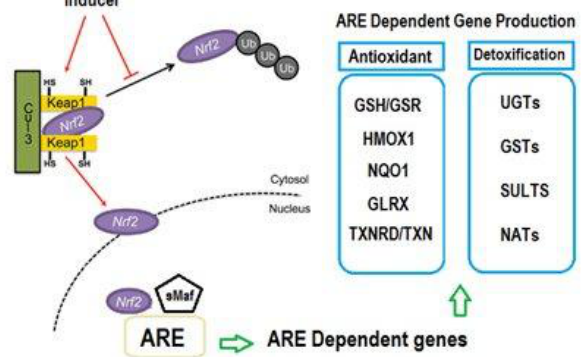
Figure 1: General scheme for the induction of cytoprotective genes through the Nrf2/Keap1/ARE-signaling